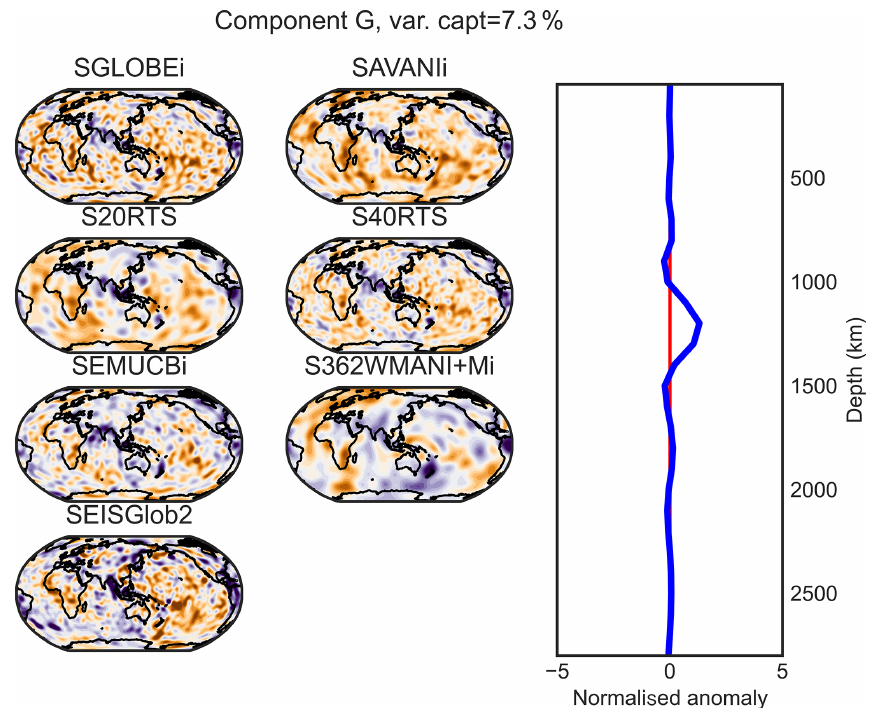
Figure D6. PC G (maximum at 1200km of depth) of the combined analysis of the isotropic parts of the models.